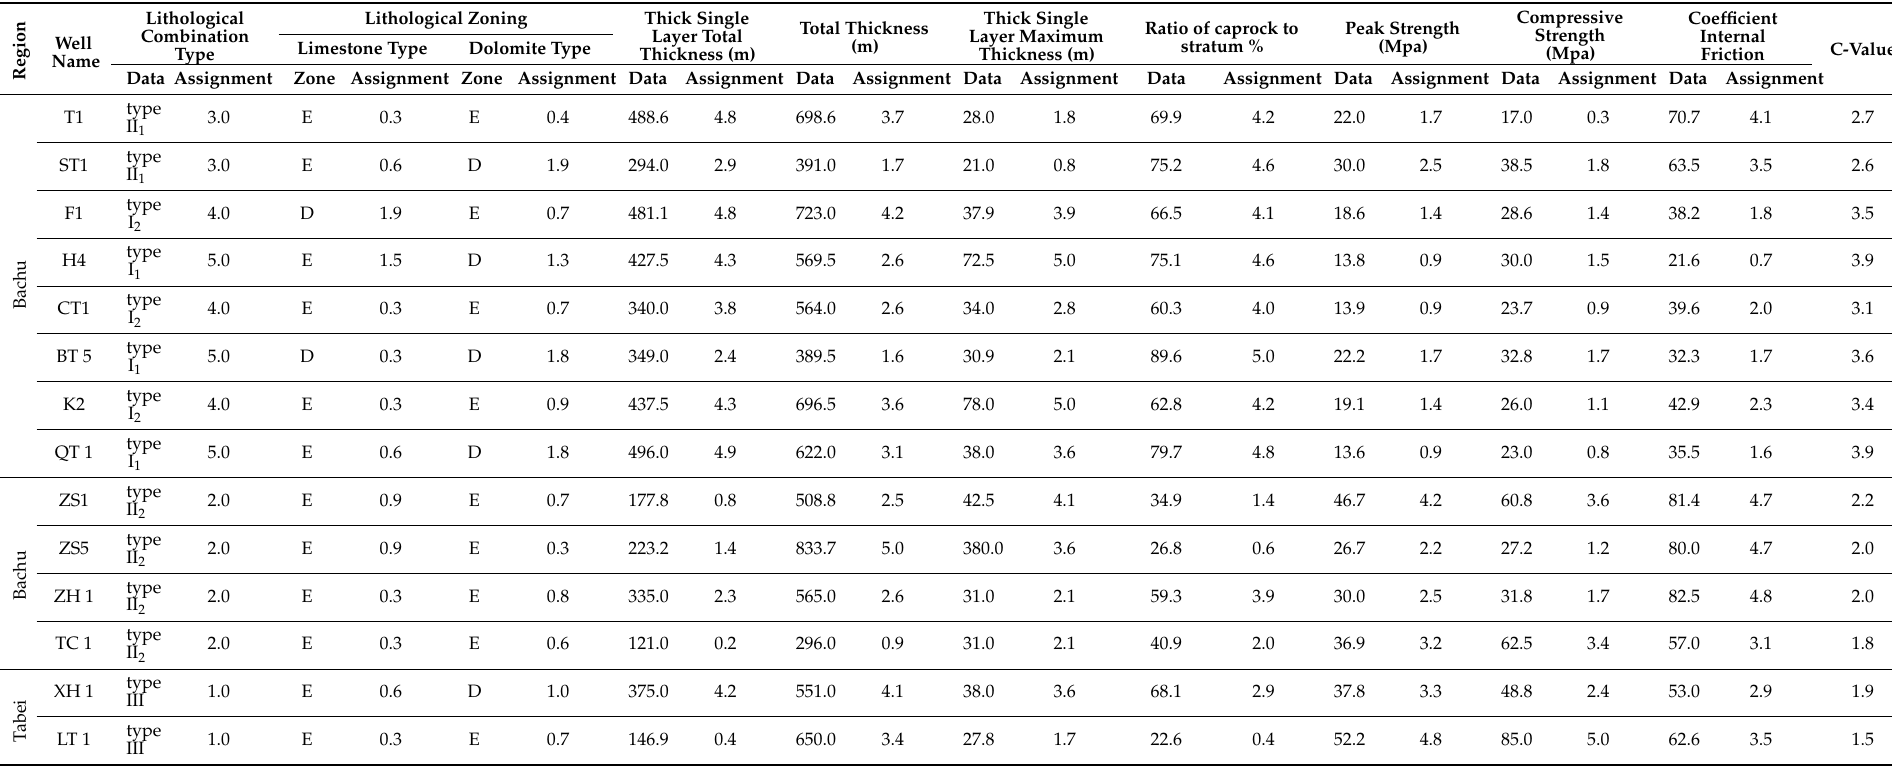
Table 7. Evaluation of sealing ability of Cambrian gypsum-salt rock type caprock in the Tarim